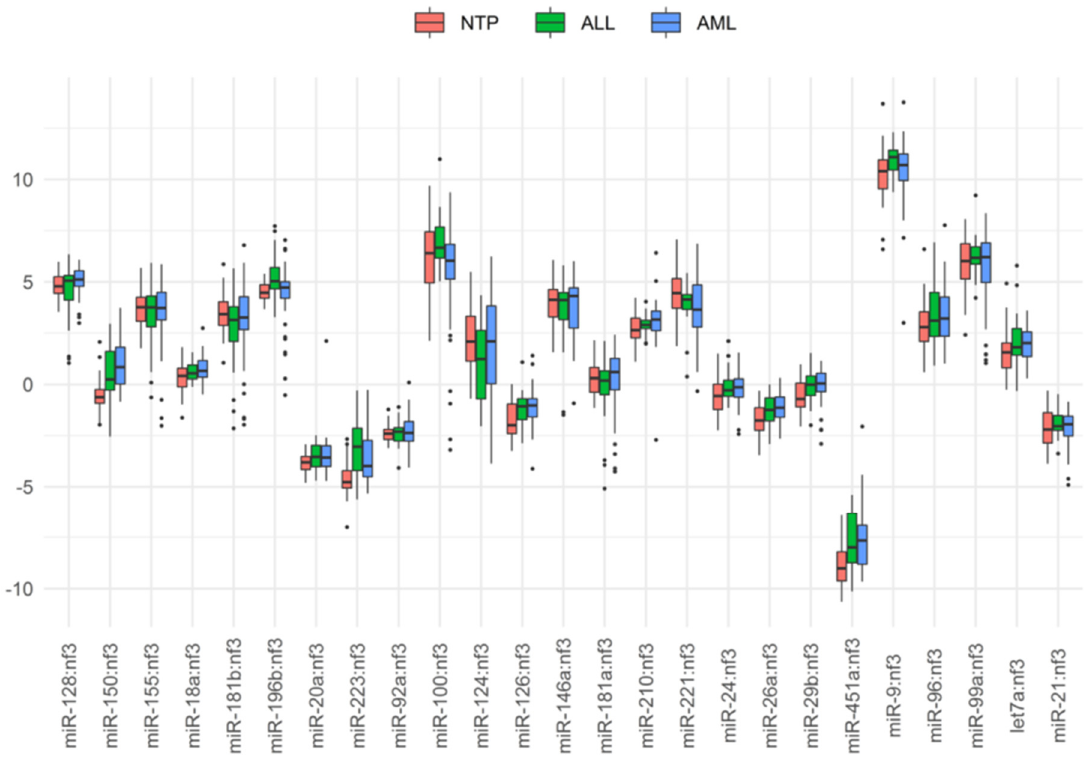
Figure 1. Boxplot for binary logarithms of some miRNA concentrations, those that were normalized to nf3. The boxes depict medians with the 1st and 3rd quartiles.